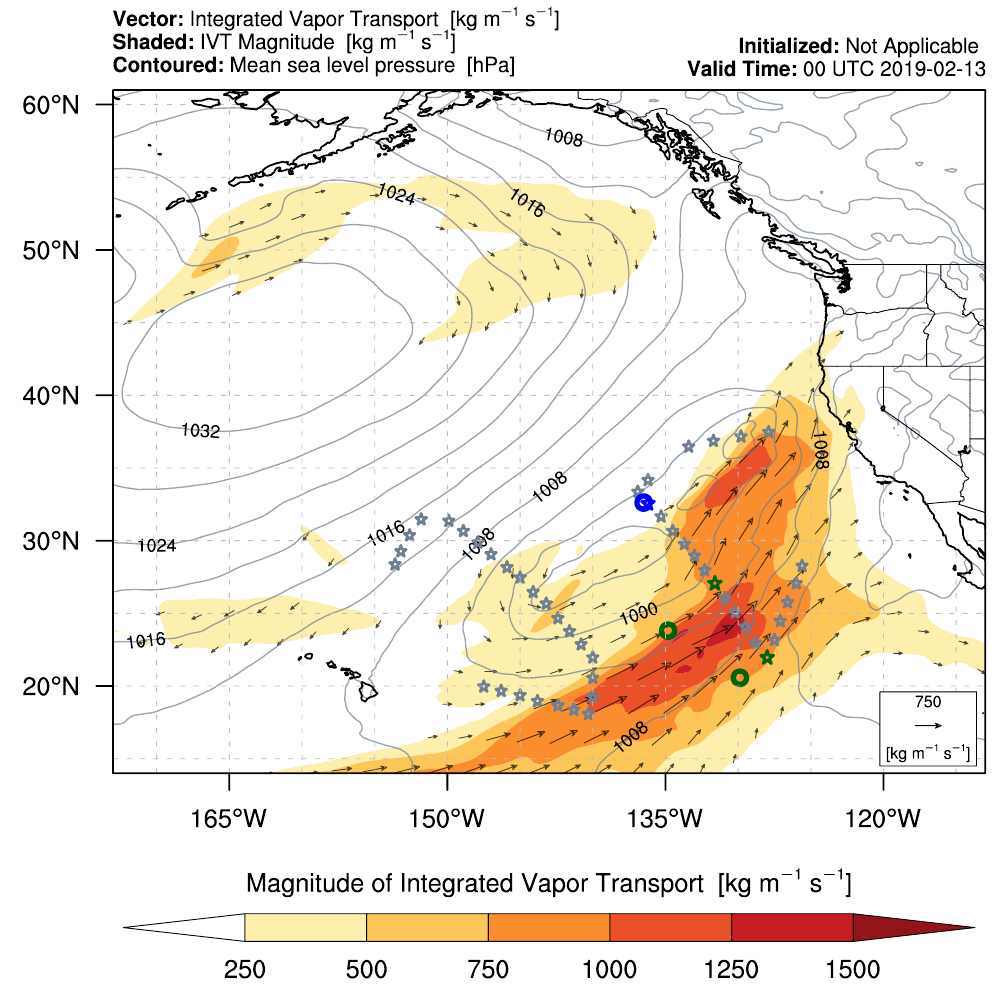
Figure 18. Overview of the third intensive observing period (IOP03) of AR Recon 2019 with inte- grated vapor transport (kg m − 1 s − 1 , shaded and vectors) and mean sea level pressure (hPa, grey contours) shown. Overlain are the locations of dropsondes (grey stars), and occultation-dropsonde pairs identified along the easternmost transect of the AR that were within 2 h and 500 km of one another, indicated by colored circles with the corresponding dropsonde indicated by a star of the same color. Occultations from the Spire and operational RO constellations are colored blue and green,